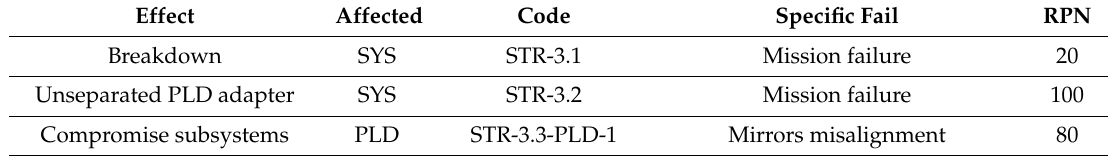
Table 16. Risk Priority Number (RPN) list for STR “Vibration” failure mode